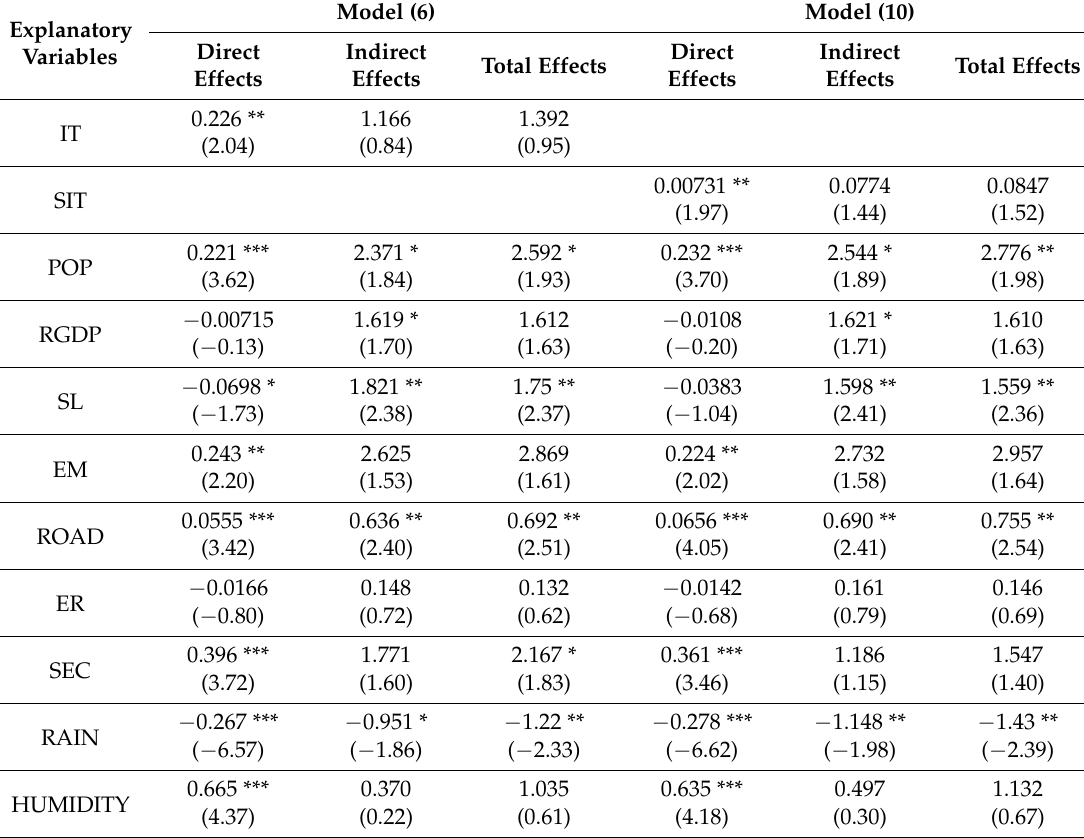
Table 7. Direct effect, space overflow effect and total effect of SDM